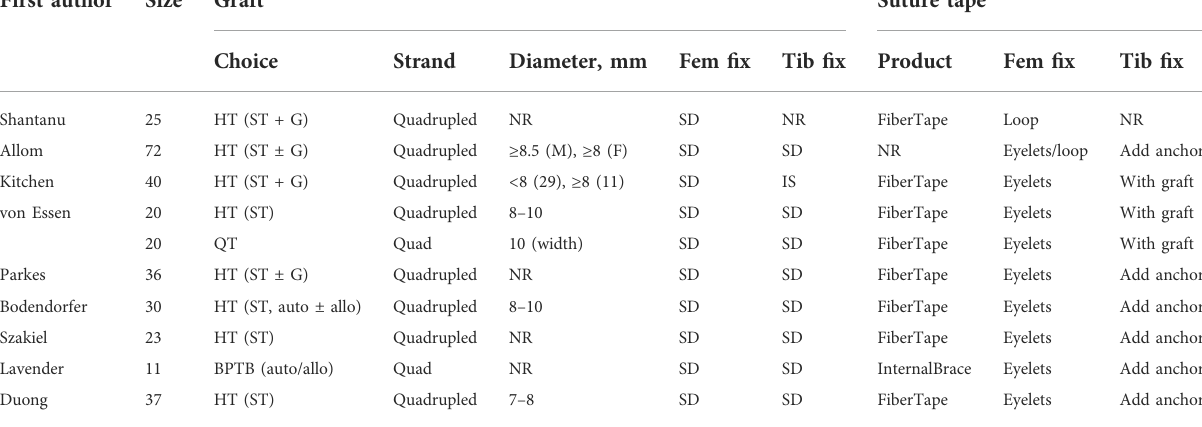
TABLE 4 Surgical technique of anterior cruciate ligament reconstruction with suture tape